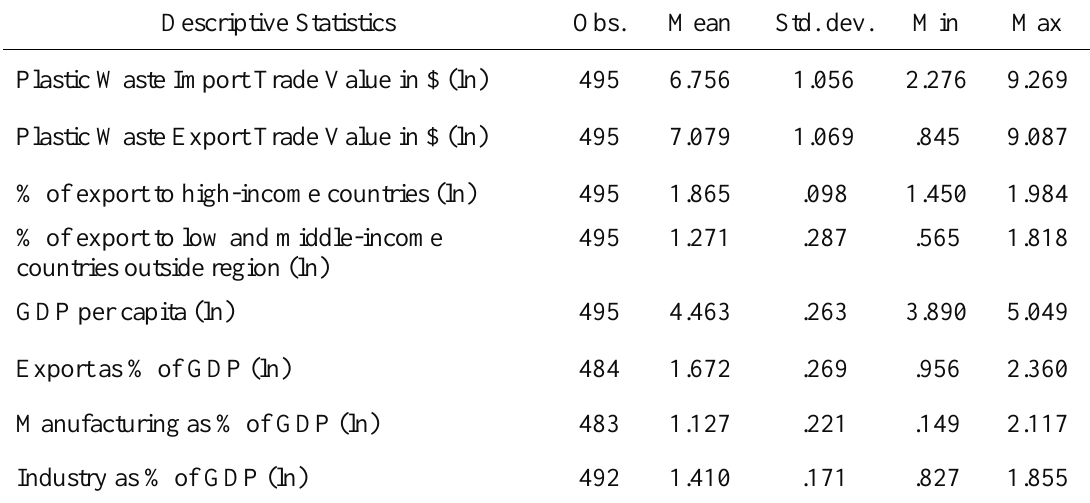
Table 3. Descriptive Statistics for 45 High-Income Countries/Regions Descriptive